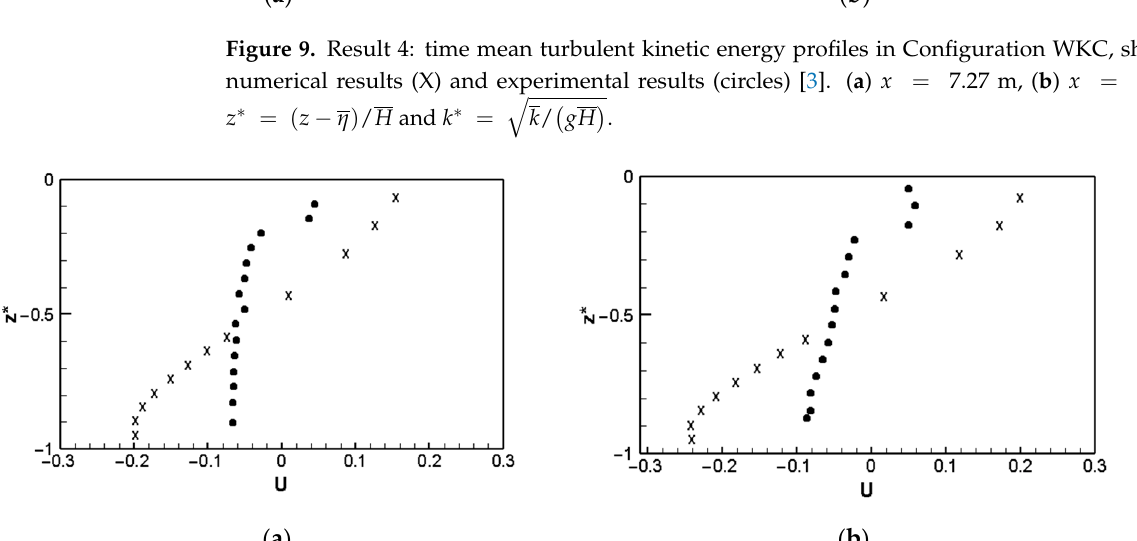
Figure 10. Result 4: undertow profiles in Configuration WKC, showing numerical results (X) and experimental results (circles) [3]. ( a ) 𝑥 = 7.27𝑚, ( b ) 𝑥 = 7.88𝑚 , 𝑧 ∗ = (𝑧 − 𝜂̅)/𝐻(cid:3365) and 𝑘 ∗ = (cid:3493)𝑘(cid:3364)/(𝑔𝐻(cid:3365)) ; 𝑧 ∗ = (𝑧 − 𝜂̅)/𝐻(cid:3365) and 𝑈 = 𝑢(cid:3364)/(cid:3493)(𝑔𝐻(cid:3365)) .